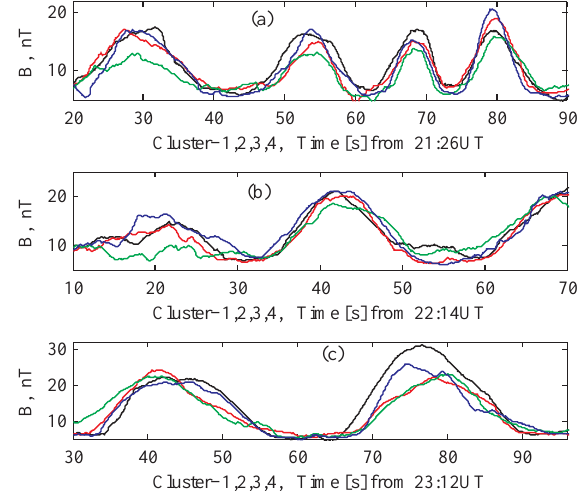
Fig. 6. Magnetic field measured on four Cluster spacecraft shifted in time to align with solitary structures seen by spacecraft C1 (black) through maximizing the correlation coefficient. The applied time shifts are listed in Table 2. Table 1. Plasma parameters for time intervals shown in Fig. 6. Ion parameters are averages from CIS-HIA instruments on C1 and C3. δV p is the standard deviation of the hot ion speed, V p .